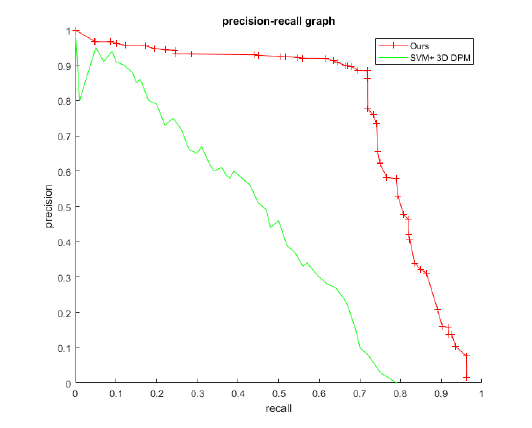
Figure 6. Precision-Recall curve of the whole dataset after iterative hard negative mining. The curve is obtained by setting different detection thresholds and is compared with SVM